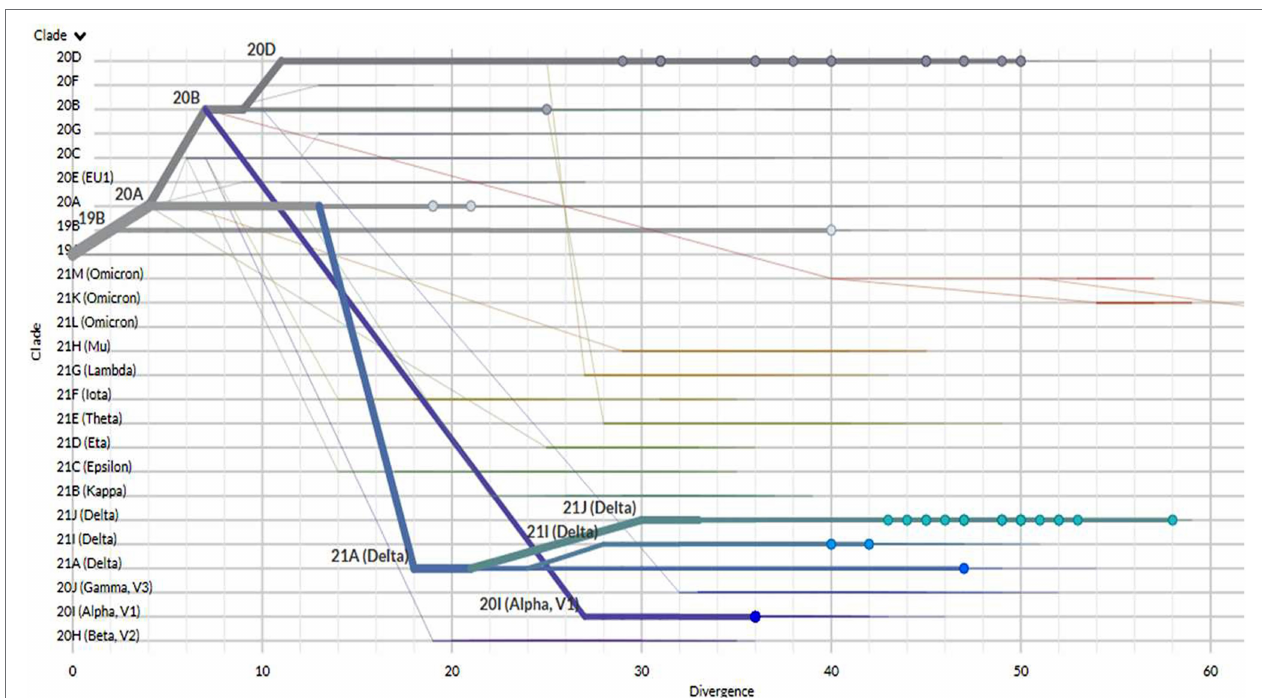
FIGURE 3 | The divergence of tested SARS-CoV-2 genomes in comparison to the reference strain